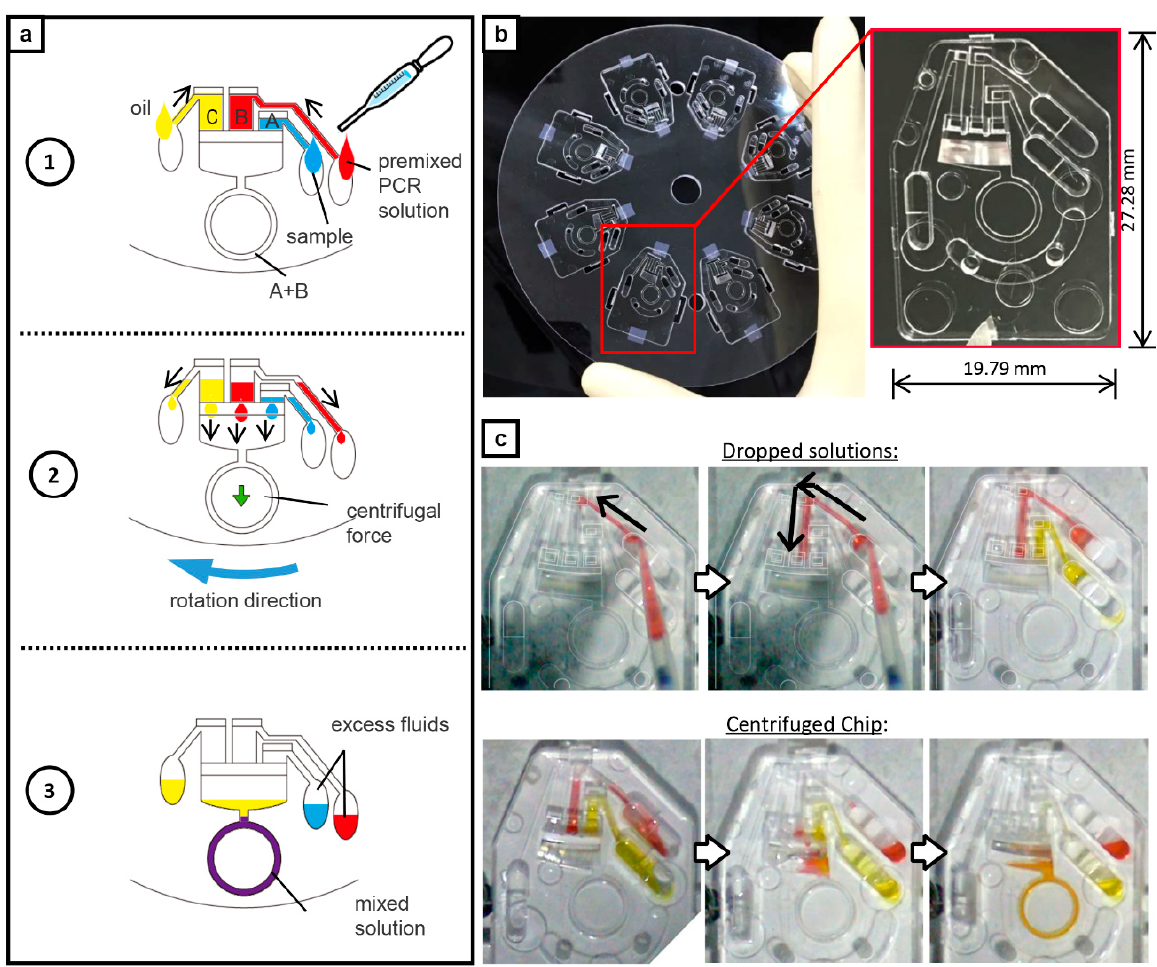
Figure 2. Point-of-care testing (POCT) version of the PCR chip; inclusion of capillary channels. ( a ) Schematics of fluid operation. 1: Liquids are dropped at each reservoir. Sample solution in area A, PCR solution in area B, and mineral oil in area C. 2: The solution is automatically dispensed and metered during rotation. 3: The mixture of the sample solution and the PCR solution enters the ring-structured channel for on-chip amplification while the mineral oil remains on top. ( b ) Applicator holding eight POCT PCR chips; all made up of COP. Inset shows the magnified view of the POCT PCR chip. ( c ) Fluid handling in the chip. The reagents are dropped to each respective reservoir. During centrifugation, the liquids enter the channel but only the PCR solutions enter the ring-structured channels. The oil at the top serves as cover in preventing the mixed PCR solutions from evaporating that could produce a failed amplification and an error in the read- ings.